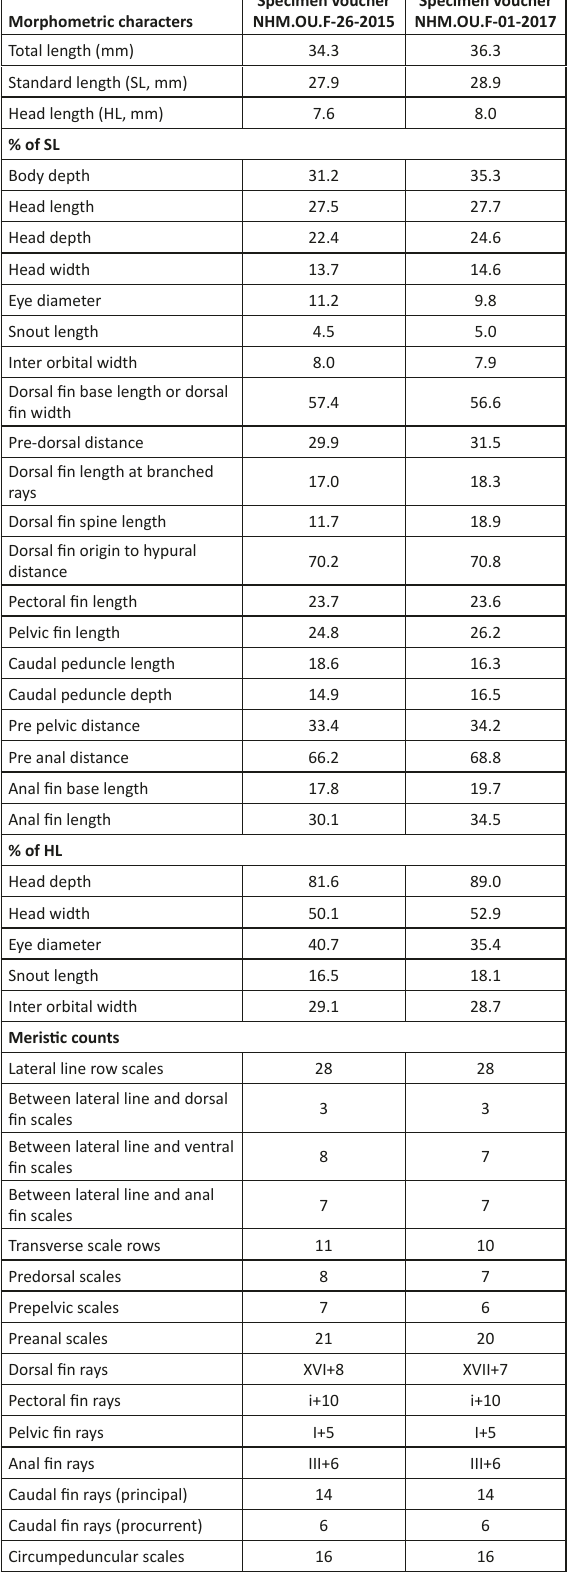
Table 1. Morphometric characters and meristic counts of Badis badis from Wardha and Manjeera sub-basins, Telangana State, India. Morphometric